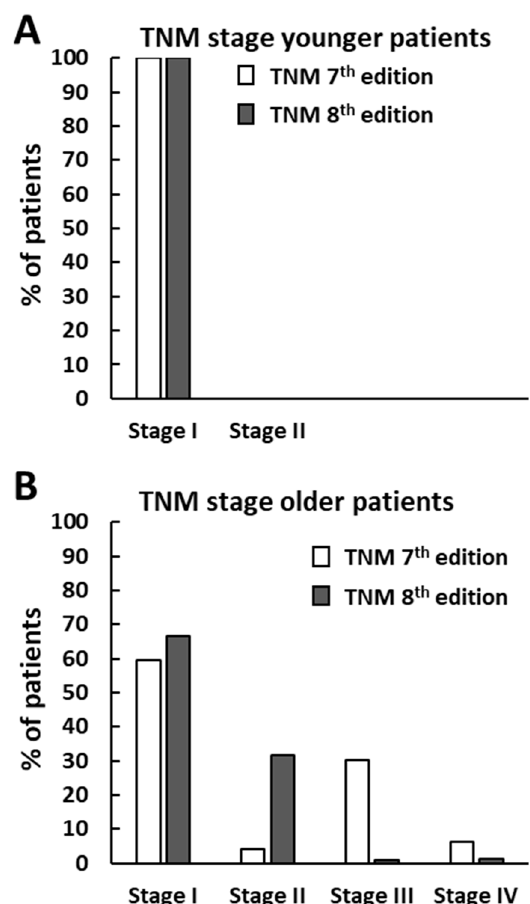
Figure 1. Distribution of 1113 papillary thyroid cancer (PTC) patients according to the 7th or the 8th Tumor-Node-Metastasis (TNM) staging system. ( A ) displays the staging of patients younger than 45 years (516 out of 1113 patients) according to the TNM-7 or younger than 55 years (764 out of 1113 patients) according to the TNM-8. ( B ) displays the distribution of stages for older patients as defined in the 7th or the 8th TNM edition.